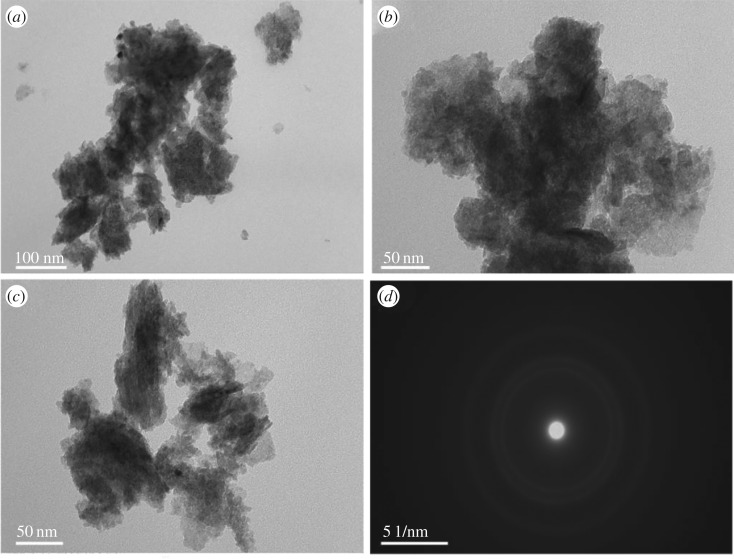
TEM images of Co0.75Ni0.25(OH)2 : D with different magnifications and locations (a–c), and the corresponding SAED pattern (d).